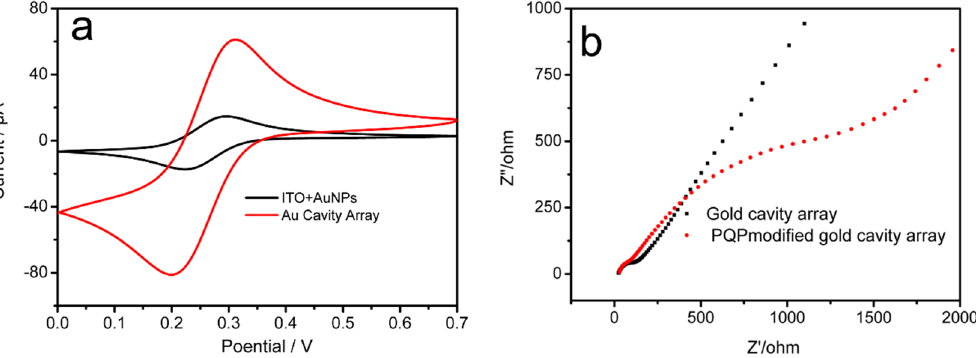
Figure 3. ( a ) CV curves of 5 mmol/L K 3 [Fe(CN) 6 ] on a bare Au electrode and the GCA electrode, ( b ) EIS curves of GCA electrode and PQT@GCA electrode. The scan rate is 0.1 V/s.